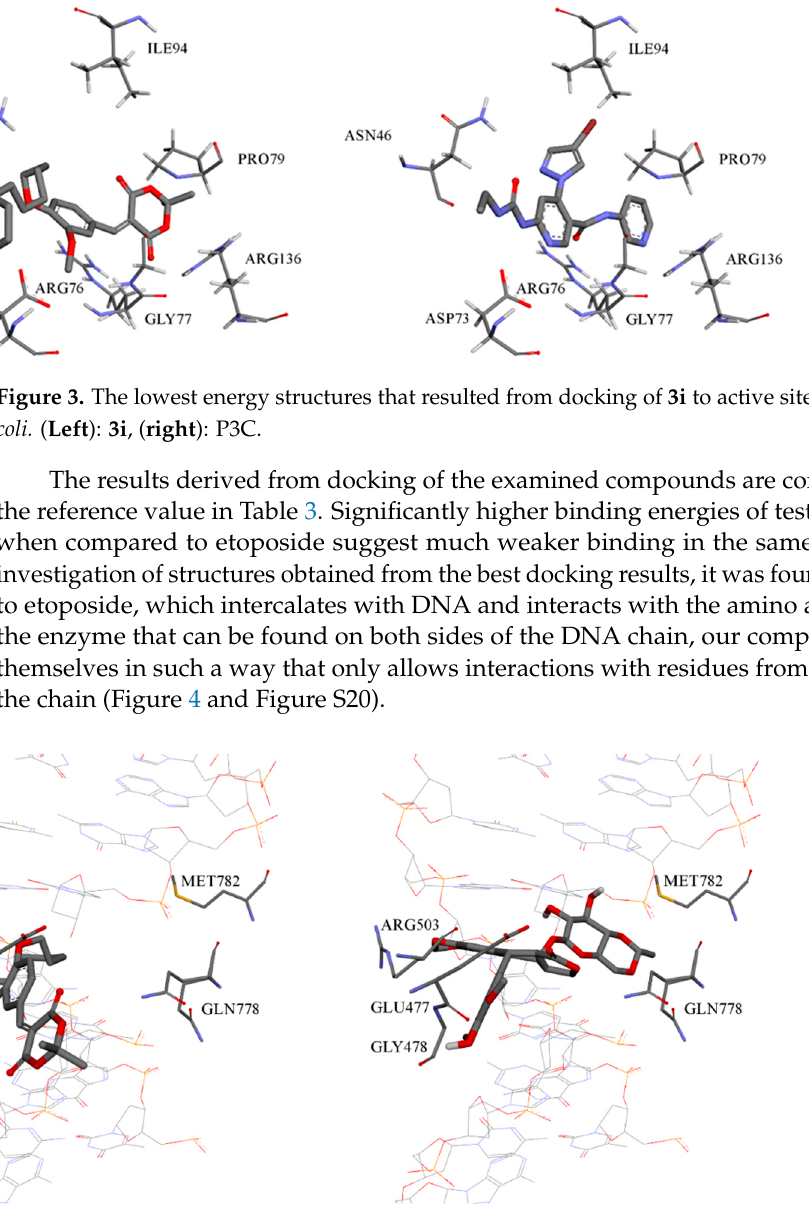
Figure 4. Comparison of binding modes for lowest energy 3i structure ( left ) and lowest energy etoposide structure ( right ).